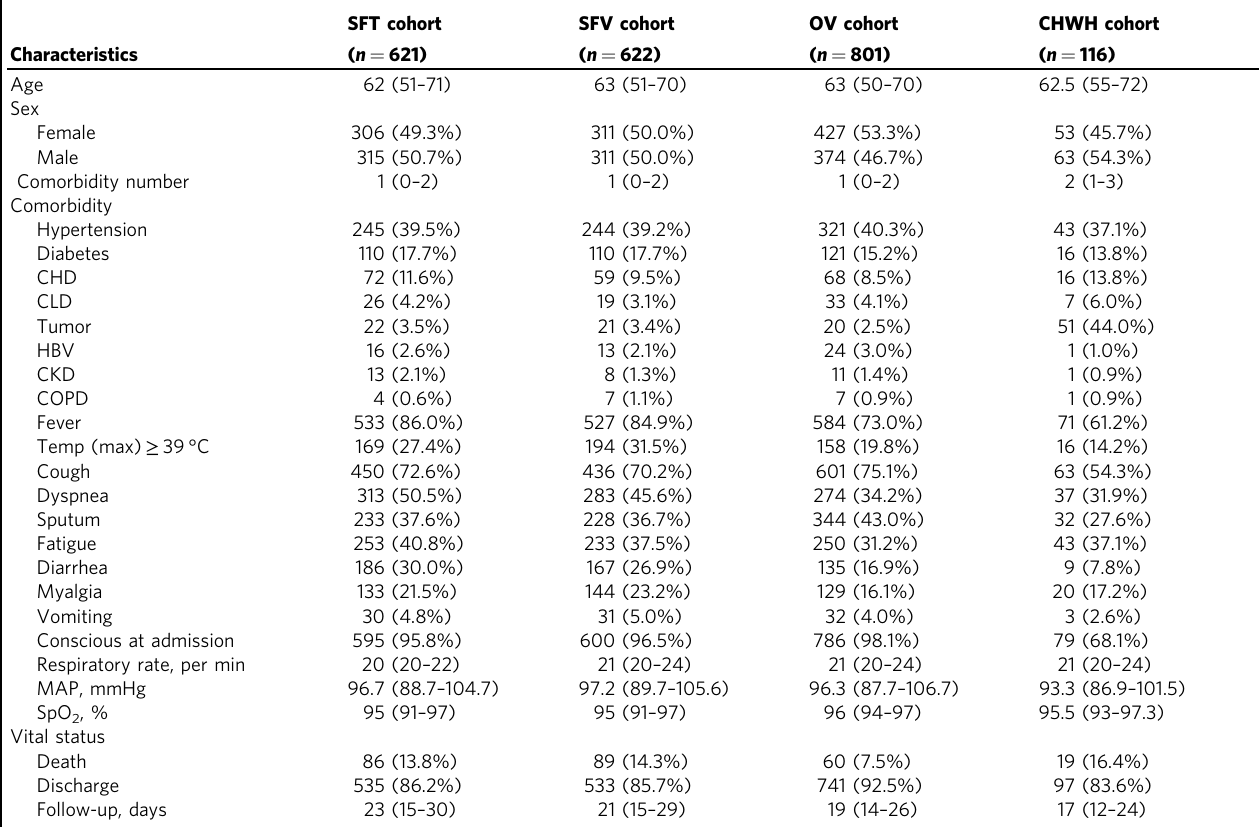
Table 1 Baseline characteristics of individuals by